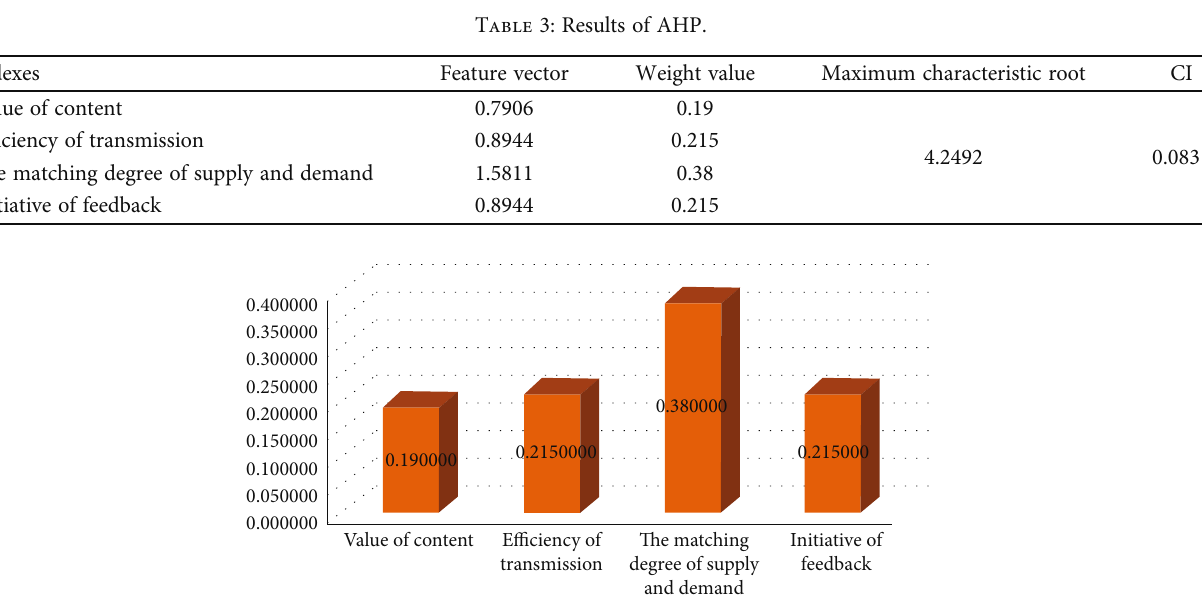
Figure 2: Weight of each index solved by